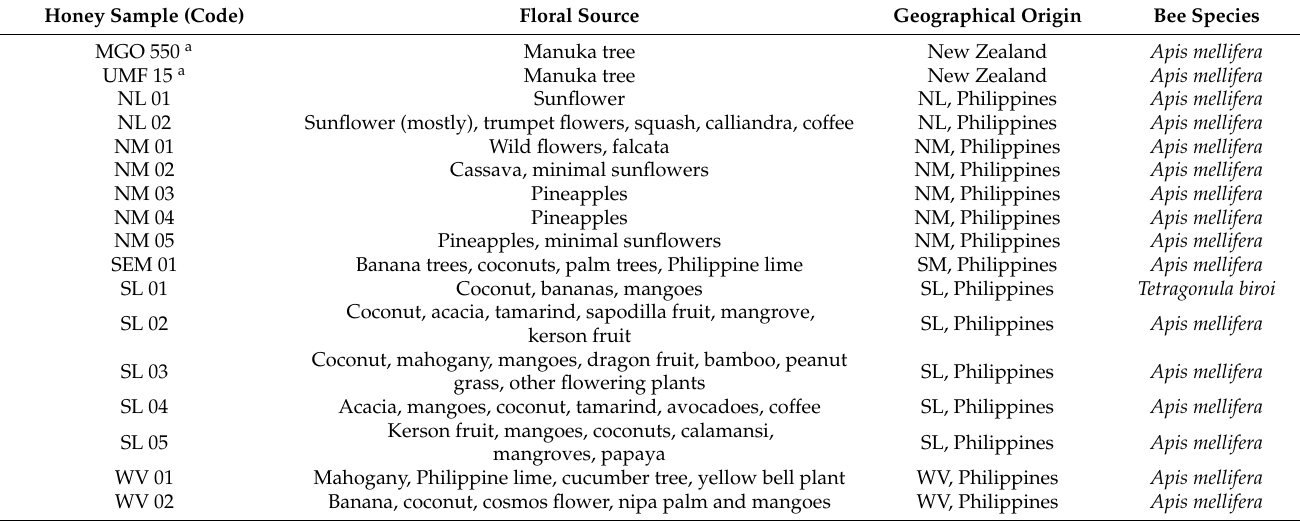
Table 1. Floral sources, harvesting region, and honey bee species.